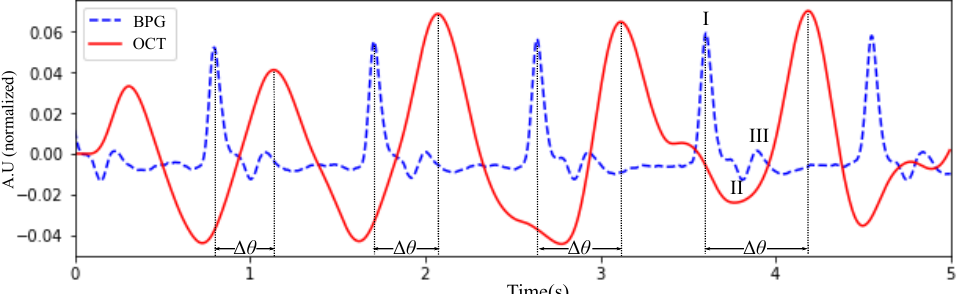
Figure 7. Synchronous comparison of the OCT PhDiff signal (OCT) and blood pressure gauge (BPG) signal. The red line denotes the OCT signal, and the blue dashed line denotes the BPG signal. The phase lag in one period of two signals (peak-to-peak) was relatively consistent. The waveform of the BPG signal consisted of local features: the systolic peak (I), dicrotic notch (II) and the diastolic peak